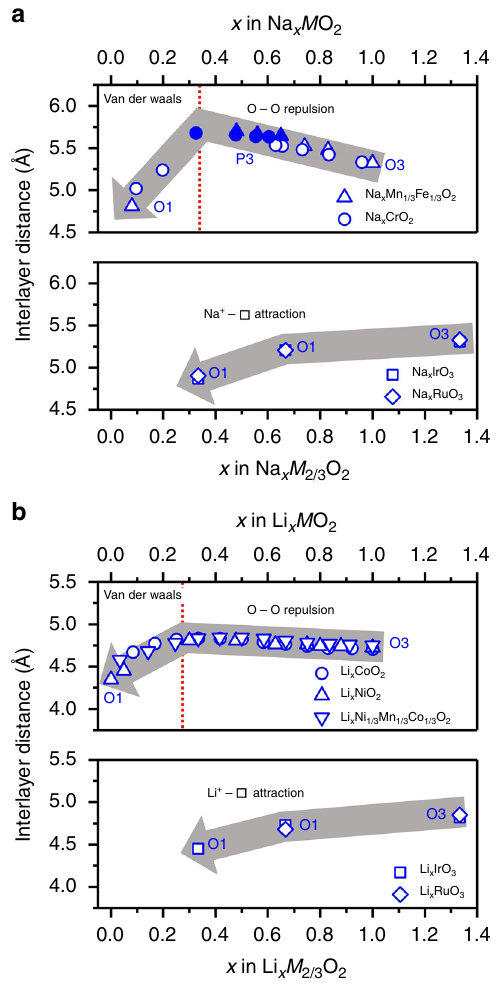
Fig. 5 Overviewing dominant forces for phase transformation during A + de-intercalation from AMO 2 and A 2 MO 3 . Comparison of the general trends in interlayer distance evolution between a Na x MO 2 (M = Cr 28 and Fe 2/3 Mn 1/3 8 ) and Na 2 MO 3 (M = Ru (this study) and Ir 22 ) and b Li x MO 2 (M = Co 4 , Ni 6 and Ni 1/3 Mn 1/3 Co 1/3 7 ) and Li x MO 3 (M = Ru 17 and Ir 18